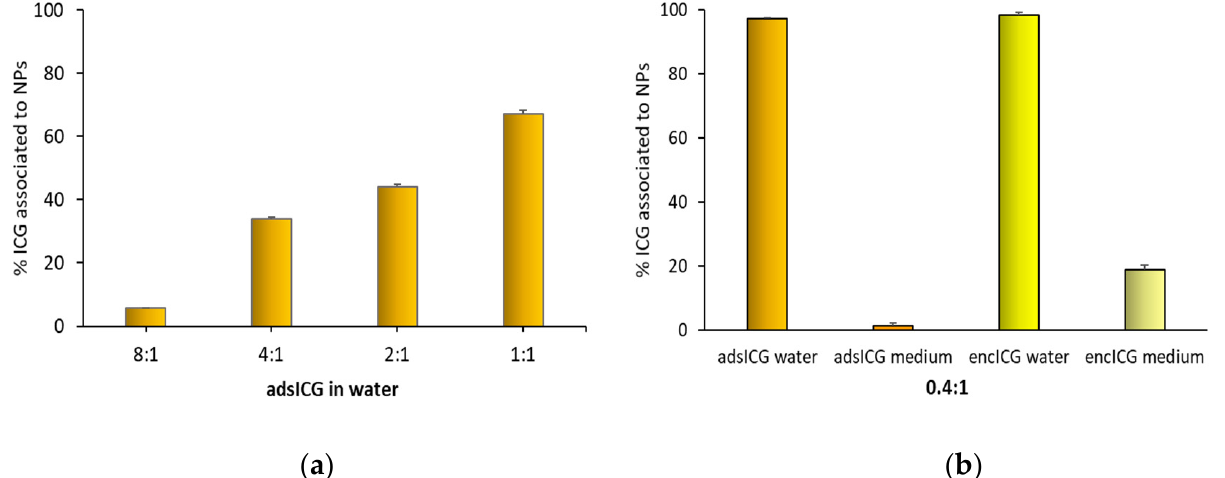
Figure 8. ICG associated with NPs. ( a ) Effect of different ICG:CS ratios for ICG loaded by adsorption in distilled water. ( b ) Effect of adsorption or encapsulation loading methods in distilled water or in DMEM medium (medium) for ads-ICG NPs and enc-ICG NPs at a 0.4:1 ICG:CS molar ratio .